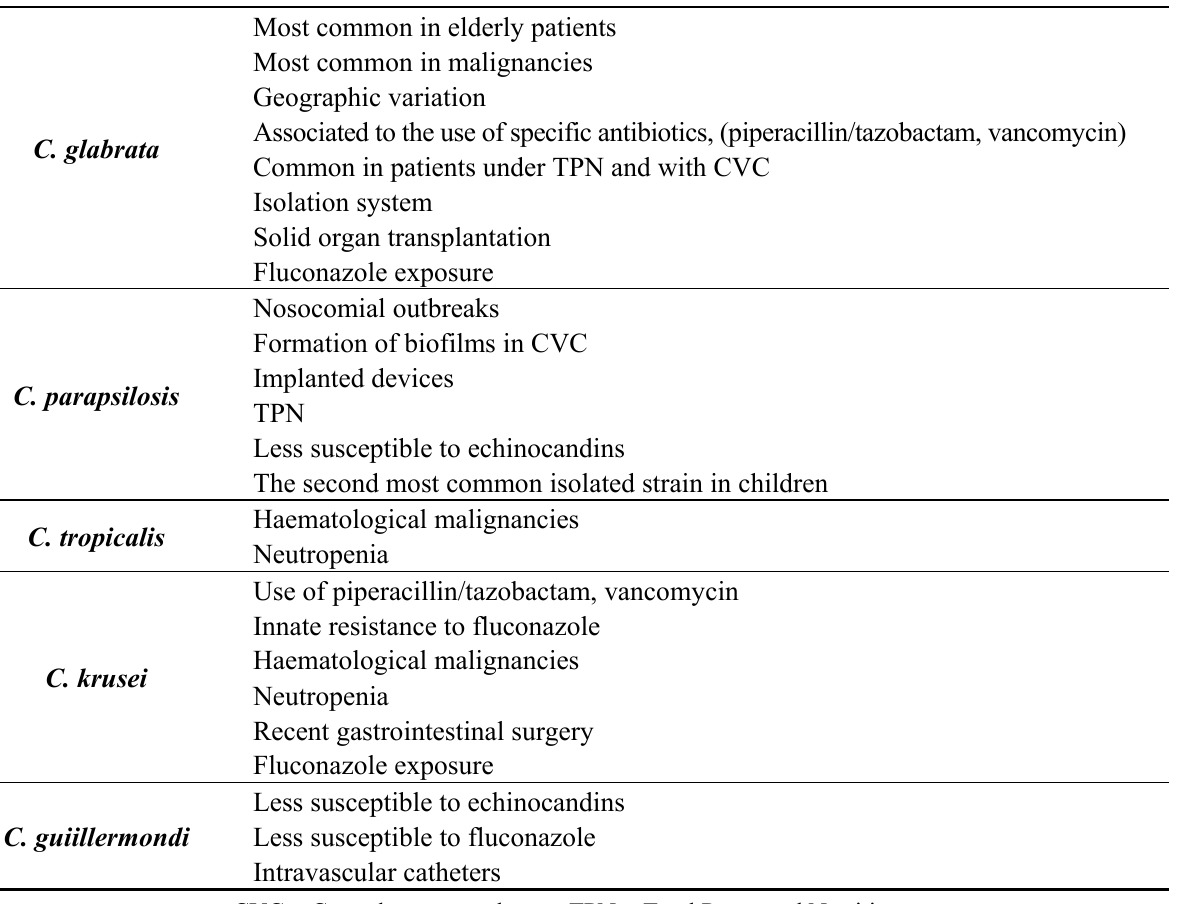
Table 1. Main characteristics and factors affecting the emergence of Candida non- albicans spp